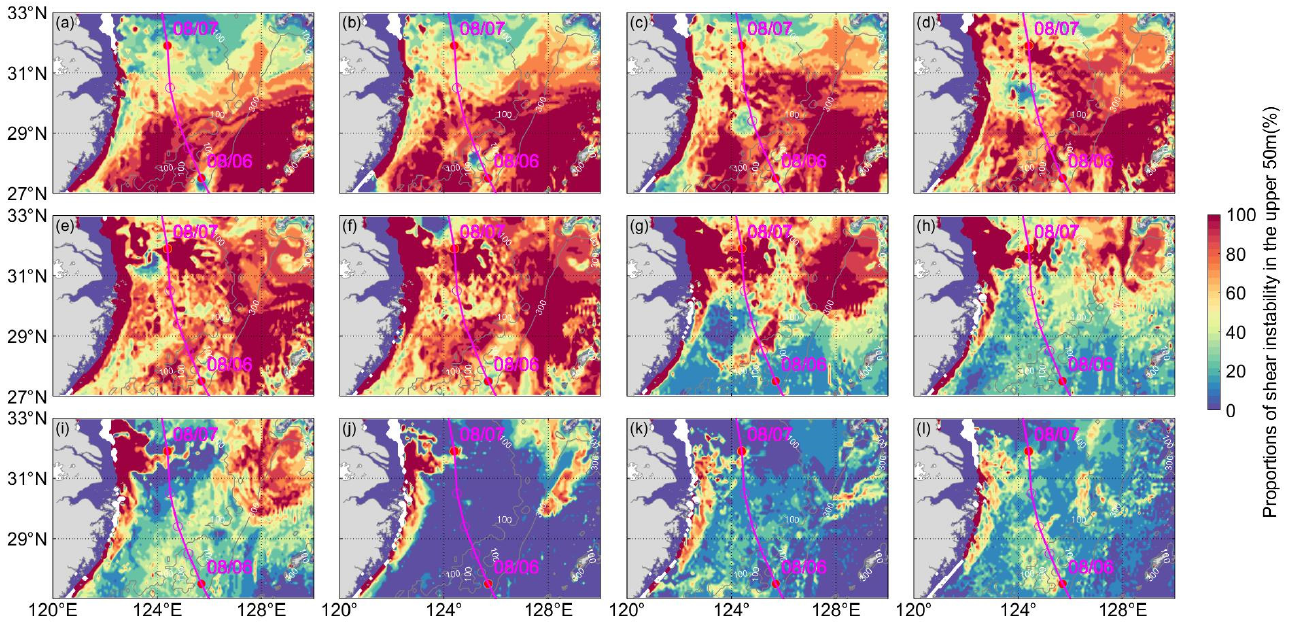
Figure 11 . Proportions of shear instability in the upper 50 m induced by typhoon Muifa from ( a – l ) 00:00 on 6 August to 18:00 on 8 00:00 on 6 August to 18:00 on 8 August with an interval of 6 August with an interval of 6 h.